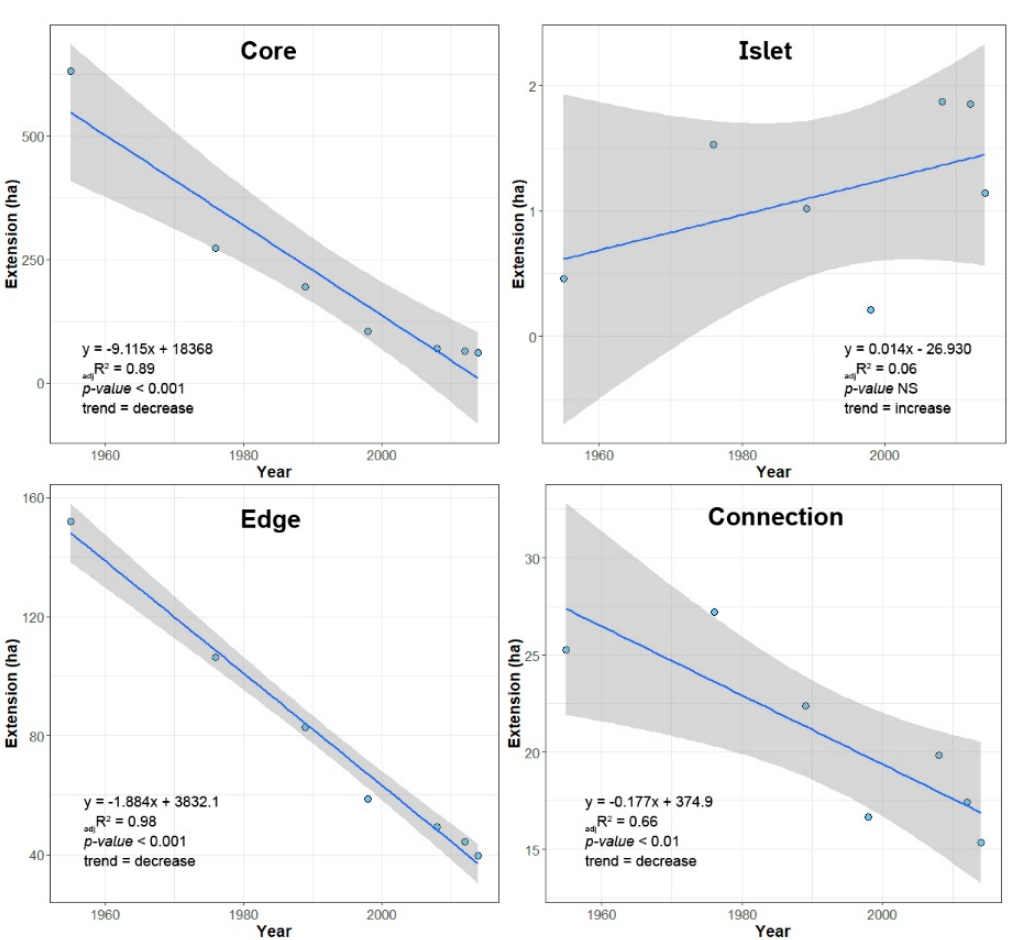
Figure 6. The time-series trend analysis of the study area’s class-level morphological spatial pattern metrics from 1955 to 2014.